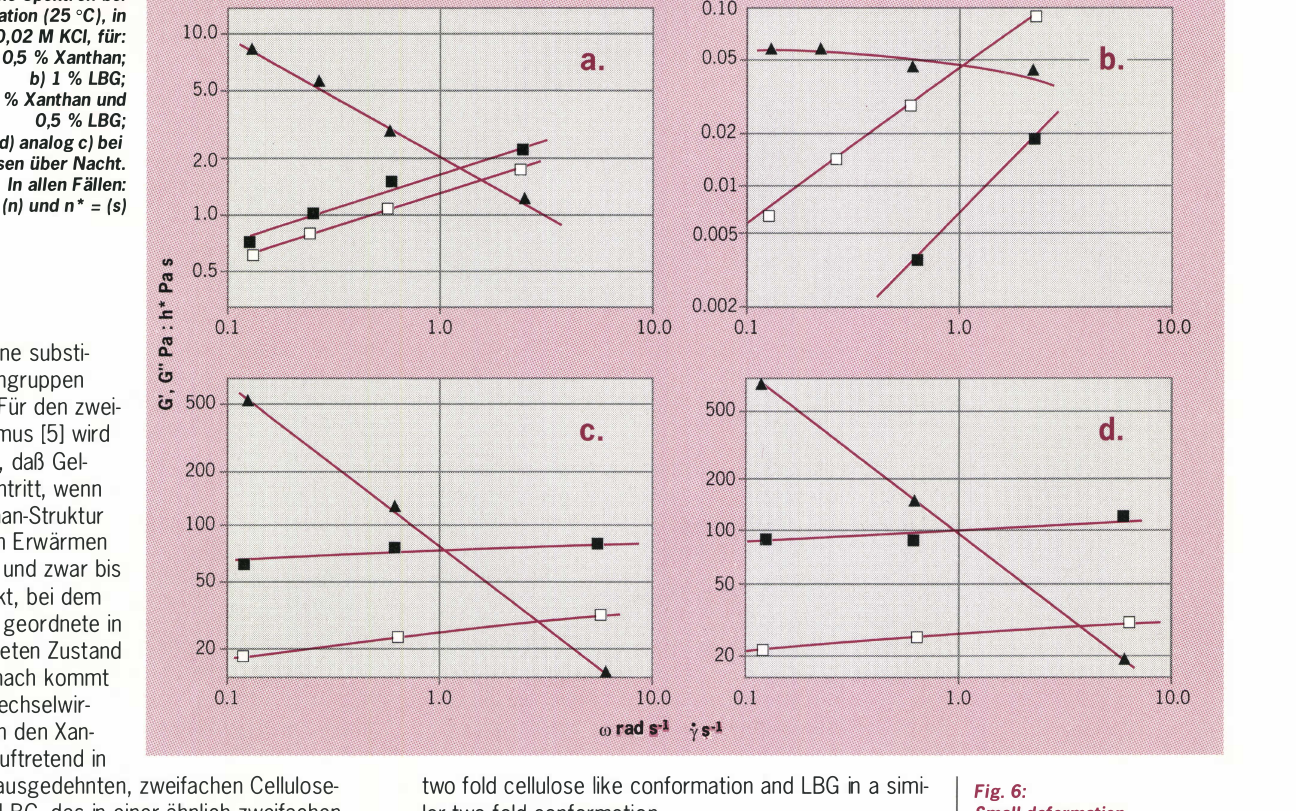
Fig. 6: Small deformation mechanical spectra at 25 oc